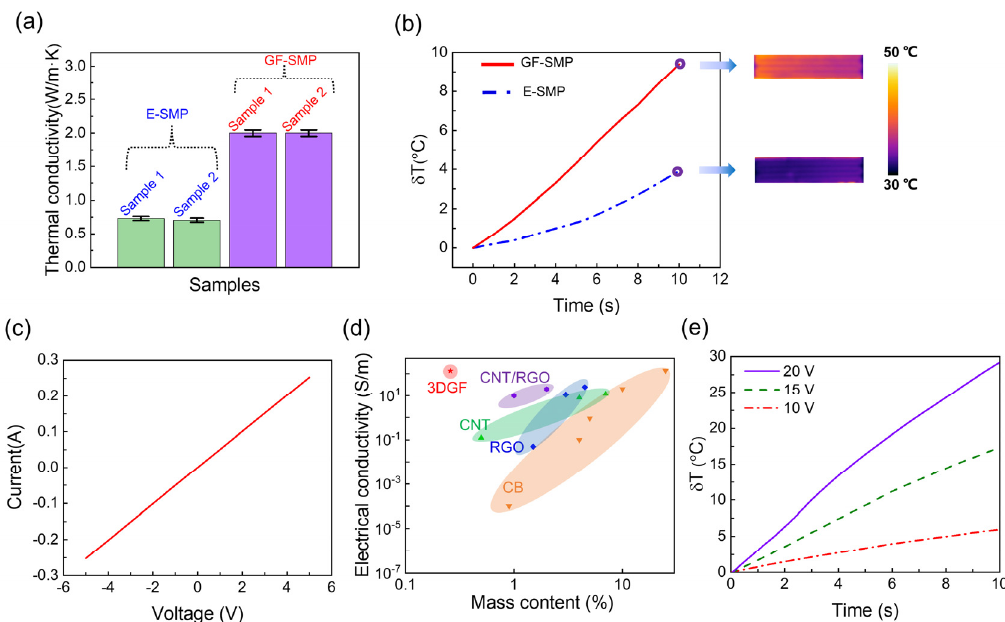
Figure 3. ( a ) Comparison of thermal conductivity of GF-SMP samples and E-SMP samples, ( b ) Comparison of temperature evolution of GF-SMP and E-SMP samples, both heated by a heating film, ( c ) I–V curve of a GF-SMP sample, ( d ) Comparison of electrical conductivity of SMP versus the mass percentage of different conductive fillers : carbon black (CB) [35–38], reduced graphene oxide (RGO) [39–41], carbon nanotube (CNT) [42,43], and reduced graphene oxide/carbon nanotube (CNT/RGO) [17,44], ( e ) Temporal evolution of temperature of a GF-SMP sample with time under different voltages.